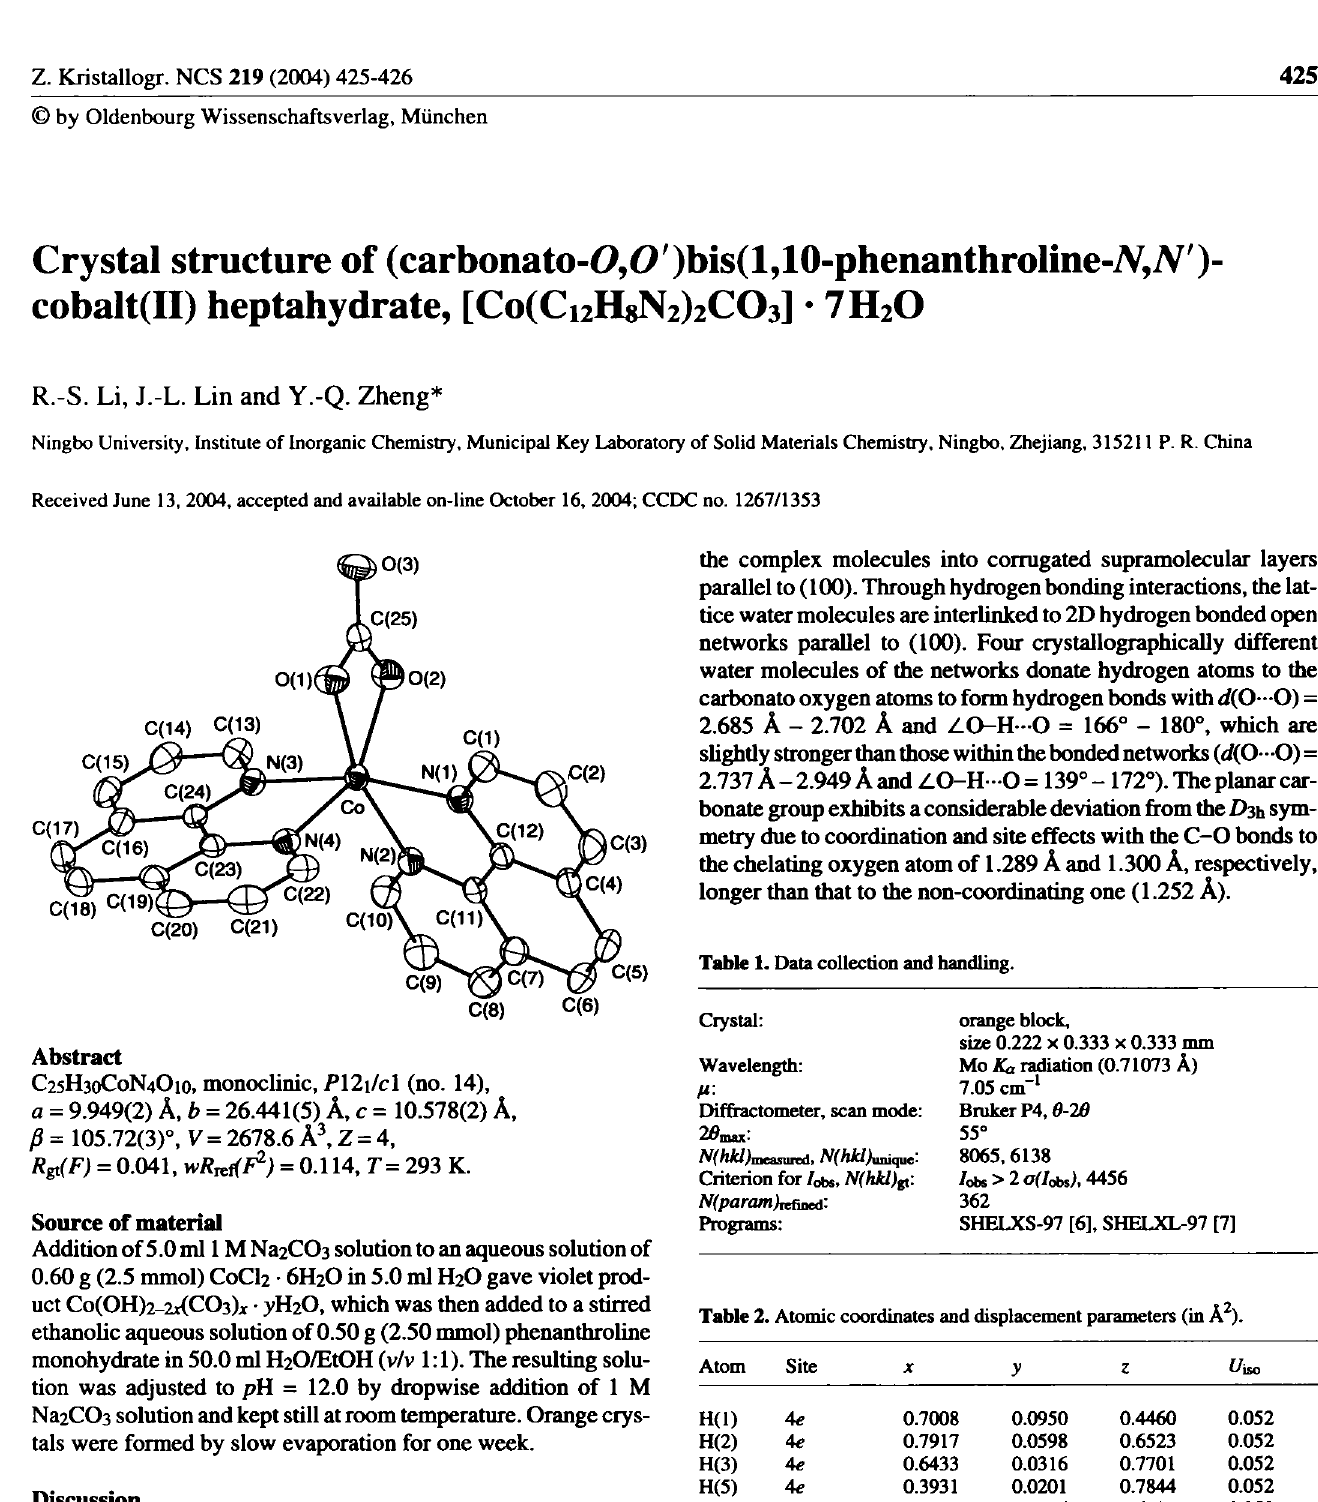
Table 2. Atomic coordinates and displacement parameters (in À 2